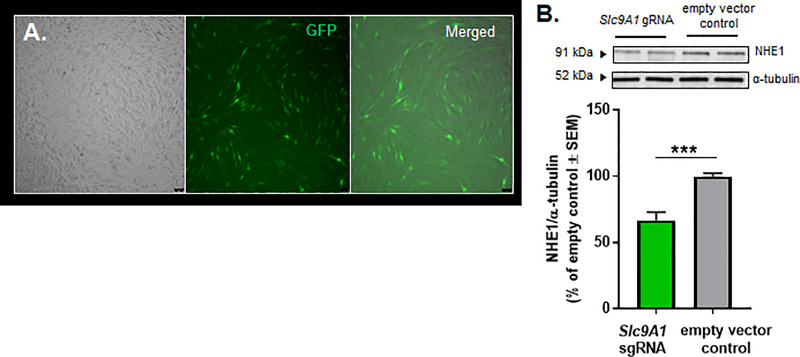
Monitoring the efficacy of CRISPR-Cas9 system in bEnd.3 cells.(A) Representative images of bEnd.3 cells infected with pL.CRISPR.EFS.GFP-Slc9A1 sgRNA show GFP-positive cells 72 hours after post-infection. (B) Representative immunoblots indicating NHE1 and α-tubulin as a loading control in the whole cell lysate of gene-edited bEnd.3 cells. Values represent the % of empty vector control ± SEM (n = 9–10). *** p = 0.0002, as assessed by unpaired t-test.